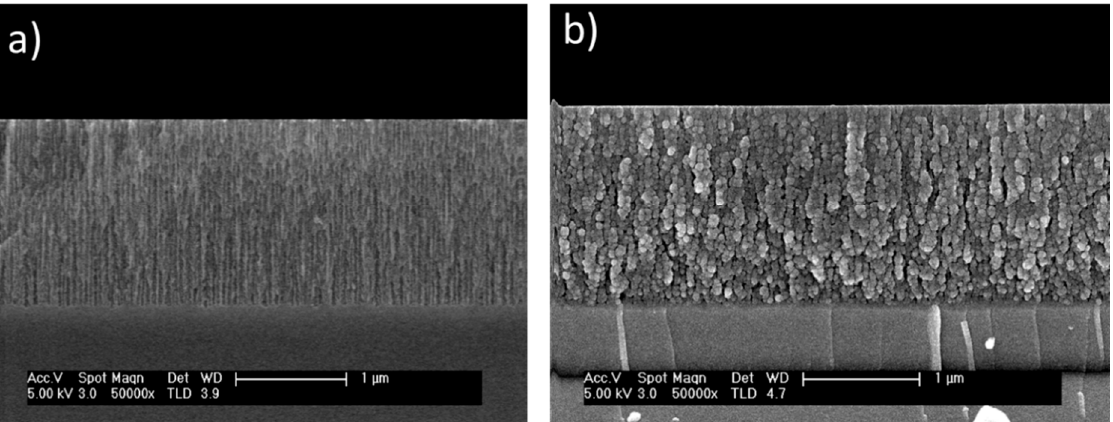
Figure 2. A cross-sectional view of a typical morphology of nanostructures Psi: ( a ) before infiltration of AgNPs and ( b ) after infiltration of AgNPs for 4 min.